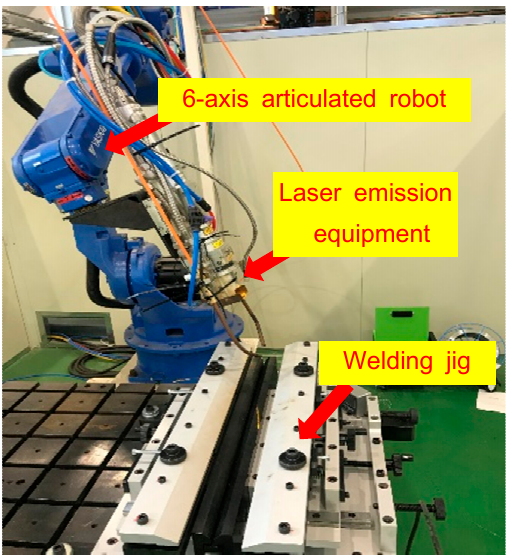
Figure 2. Fiber laser welding system with jig.